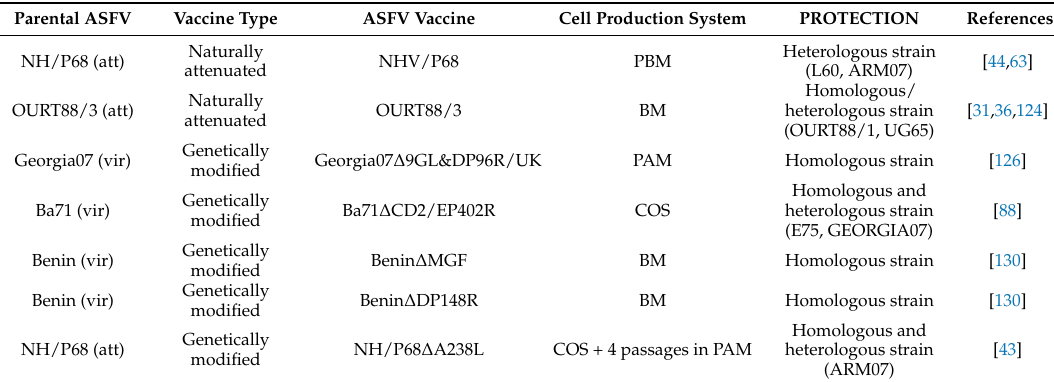
Table 2. Promising progress towards the development of a ASFV